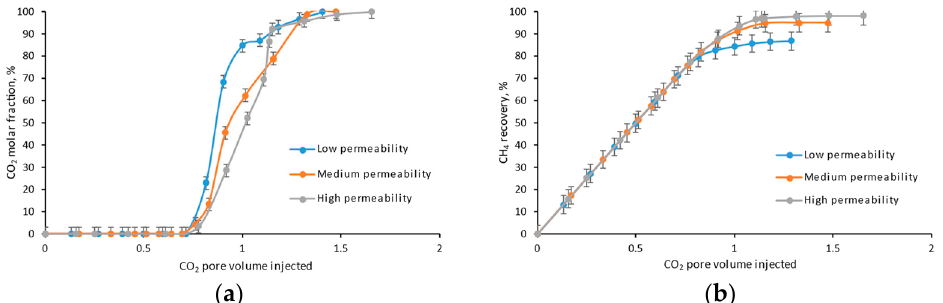
Figure 15. The variation curves under different permeabilities. ( a ) CO 2 content at the long core outlet; ( b ) CH 4 recovery.